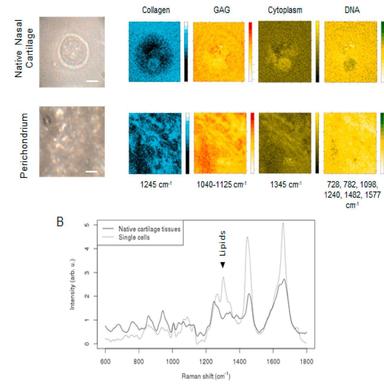
(A) Bright field images and 20 μm × 20 μm Raman images of native nasal cartilage and perichondrium colored based on specific peak intensities. (B) Mean Raman spectra from native cartilage tissue and chondrocytes.